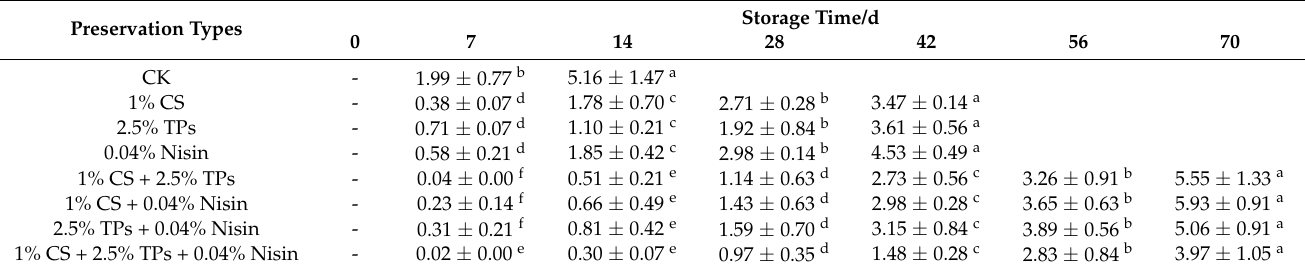
Table 4. Changes in the turnover of plant-based meat juices treated with compound